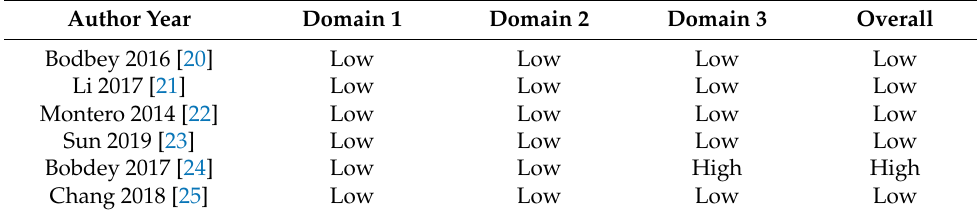
Table 4. Applicability of the developed prognostic models.